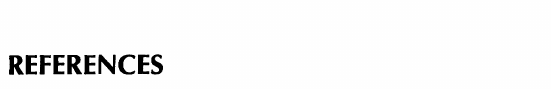
found to exist in the range of frequencies corre sponding to common gaps in the spectrum of con stituent regular periodic composites that are con structed from the cells of the disordered system. For those frequencies, waves propagate only a (short) finite distance and are therefore strongly localized modes in a composite of fairly large